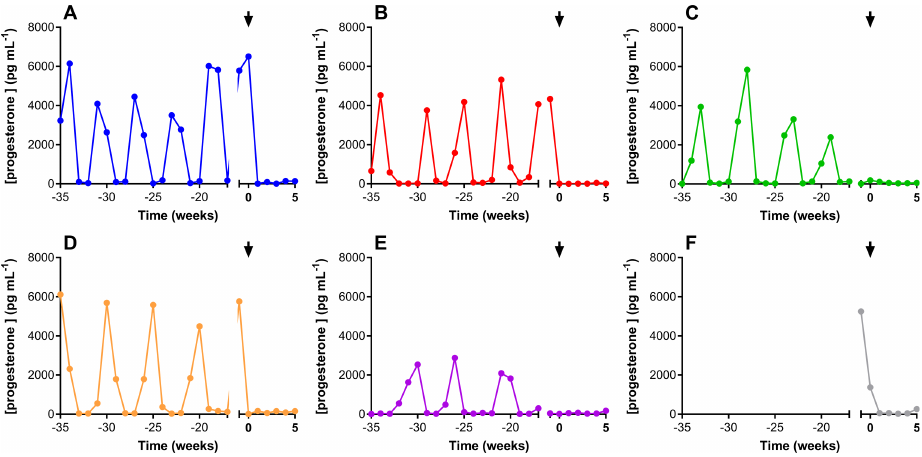
Fig 8. Plasma progesterone concentrations over 40-weekperiod. Each panel representsone animal; the arrow indicatesthe placementof the Configuration A pod-IVR (week 0).